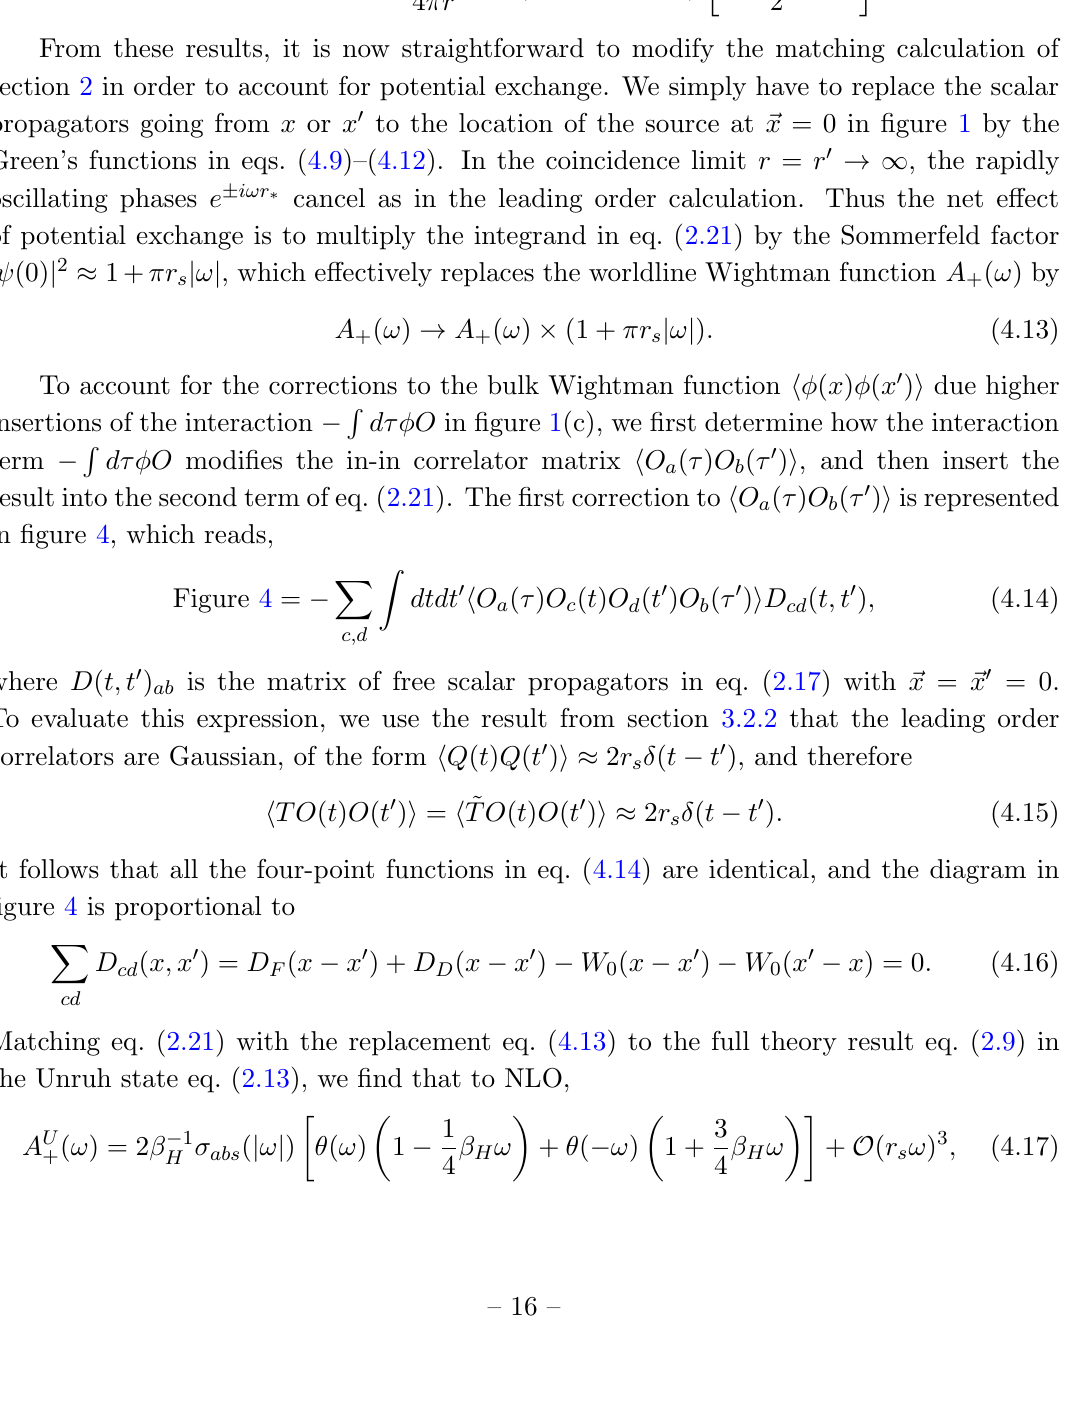
Figure 4 . Leading order correction to the in-in two-point functions to the expression in eq.